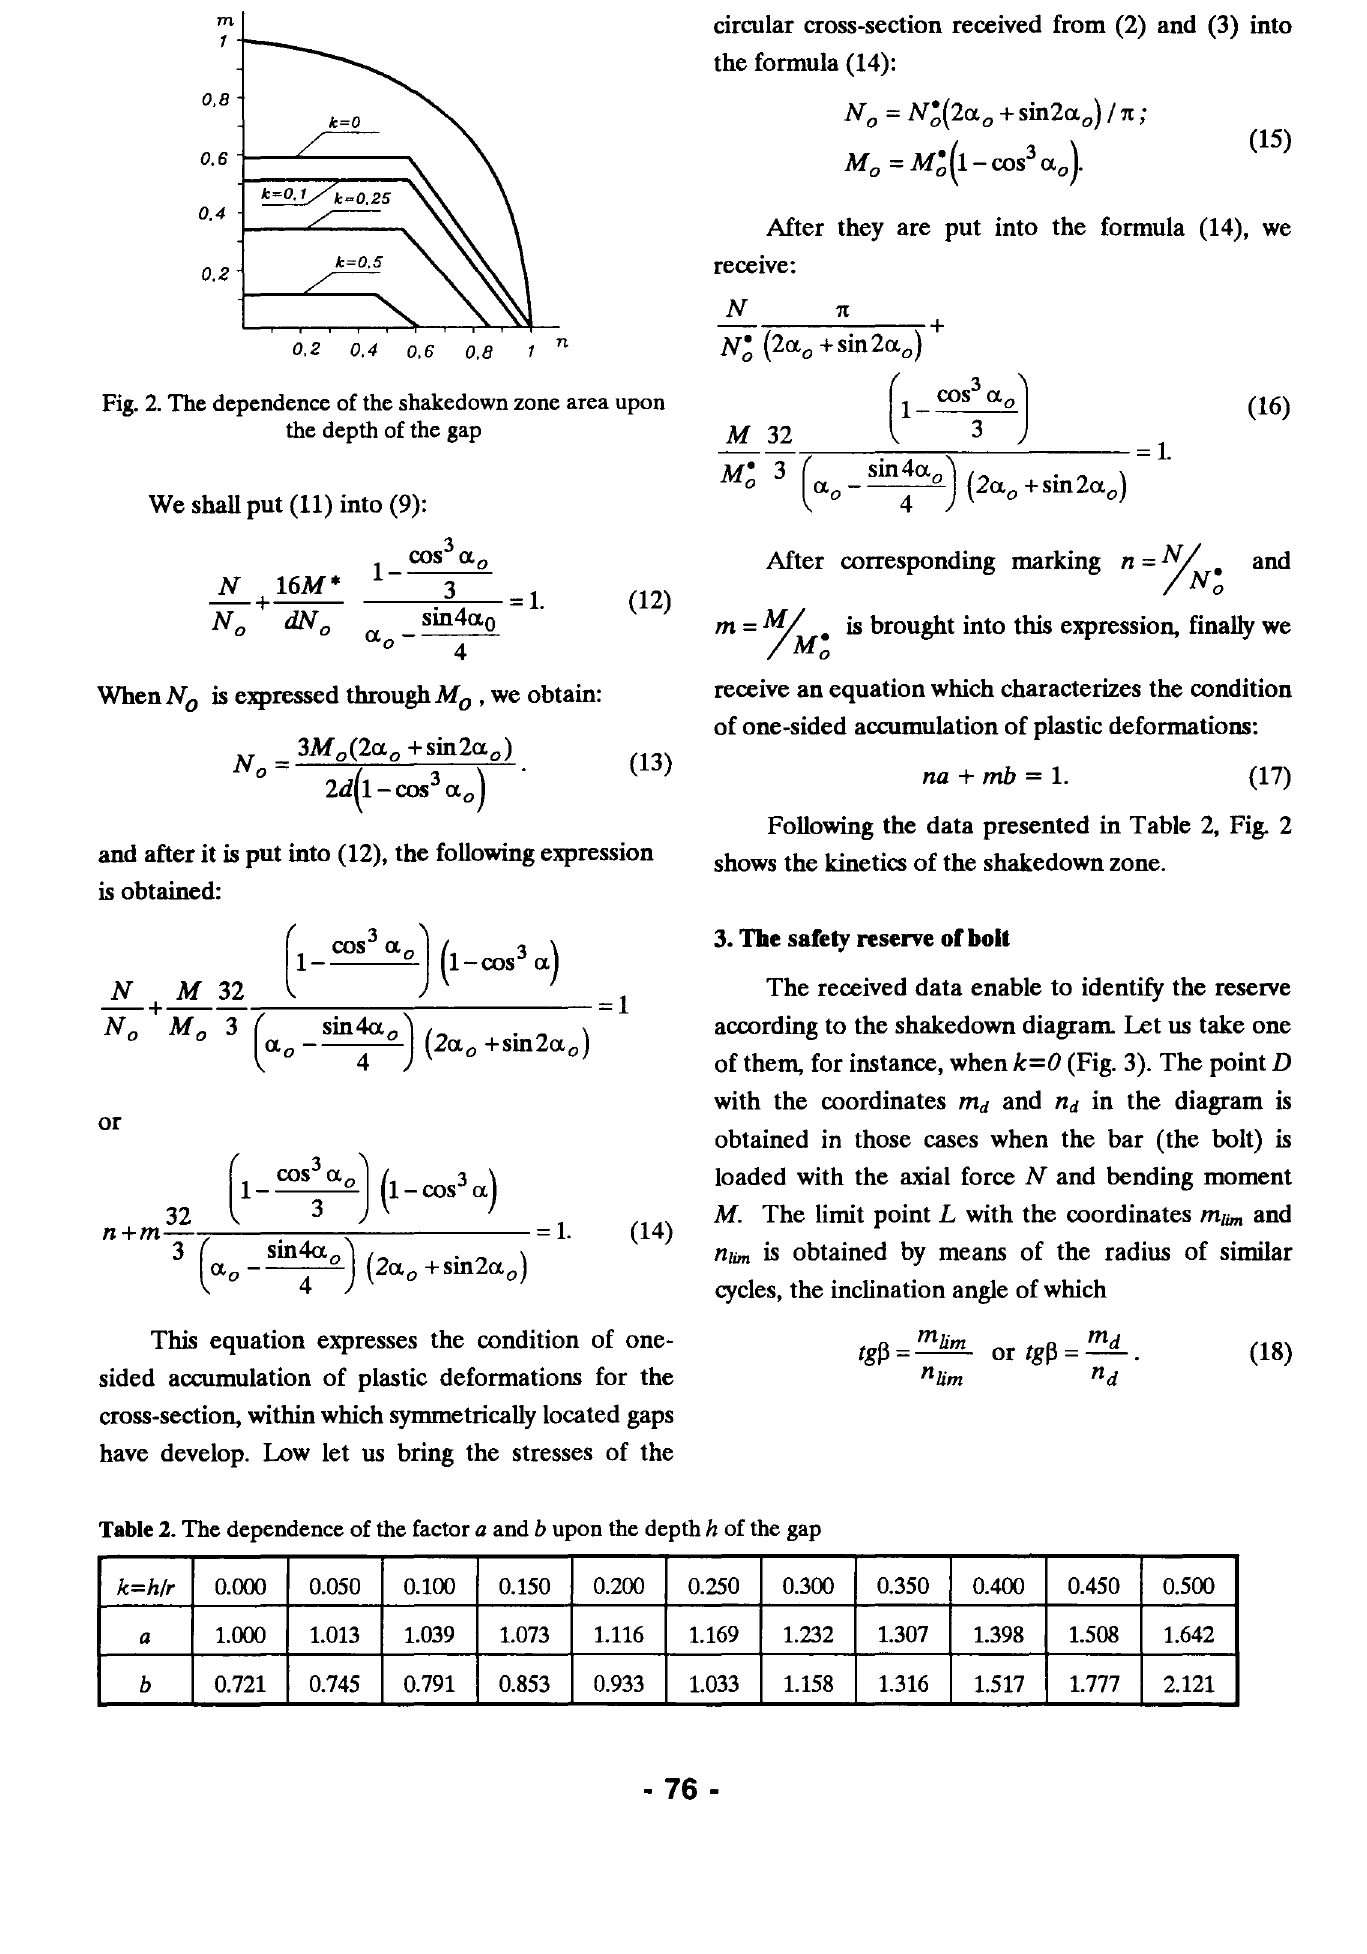
Fig. 2. The dependence of the shakedown zone area upon the depth of the gap